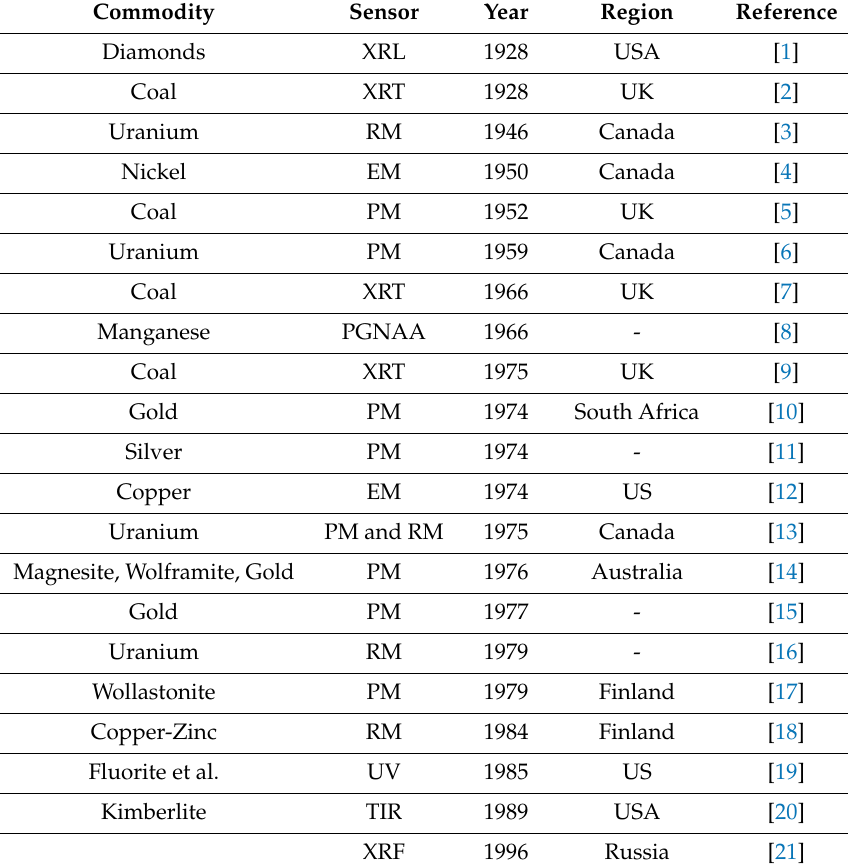
Table 2. Timeline on sensor-based ore sorting